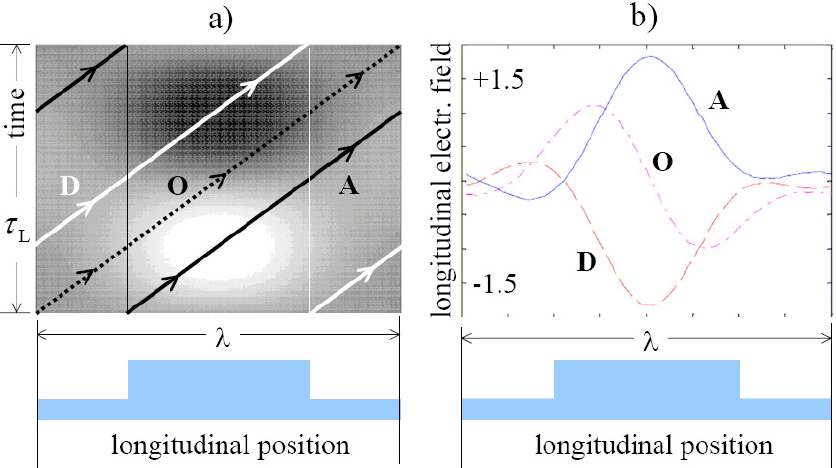
FIG. 3. (Color) (a) Map of the accelerating electric field component as a function of elapsed time and position at the center of the vacuum channel. The lines indicate the trajectory of a relativistic particle at an accelerating phase A , a decelerating phase D , and a phase of no energy change O . (b) The longitudinal electric field component along these particle trajectories down the center of the vacuum channel. The electric field magnitude of these traces corresponds to an input plane wave of amplitude E